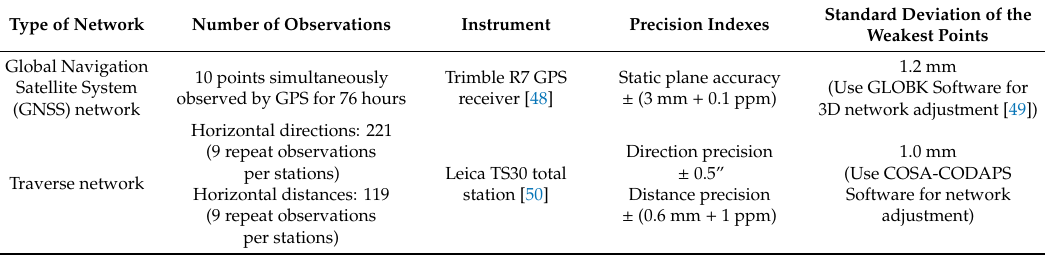
Figure 3. Design of the experimental network. Table 1. Design of the experimental network.